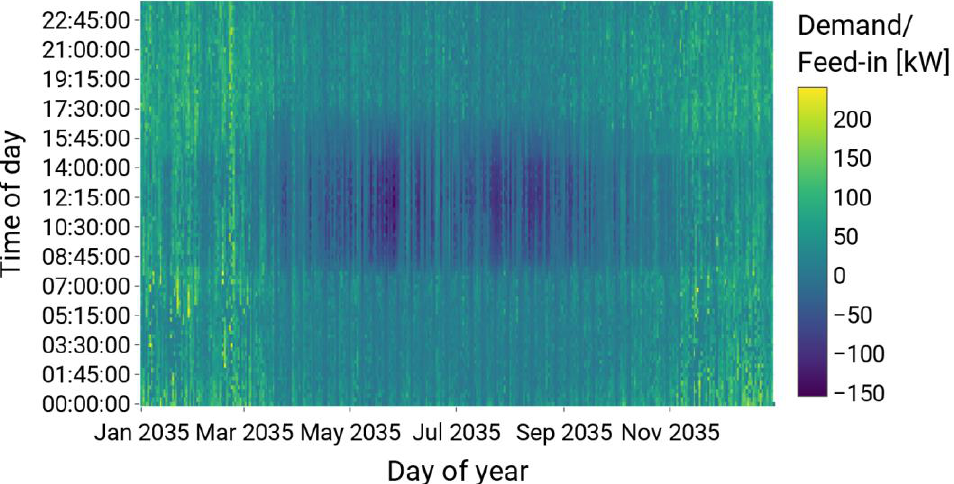
Figure 7. Heatmap of the electric demand (positive values) and feed-in (negative values) for the scenario with time variable fees, the scenario year 2035 and the rural grid.